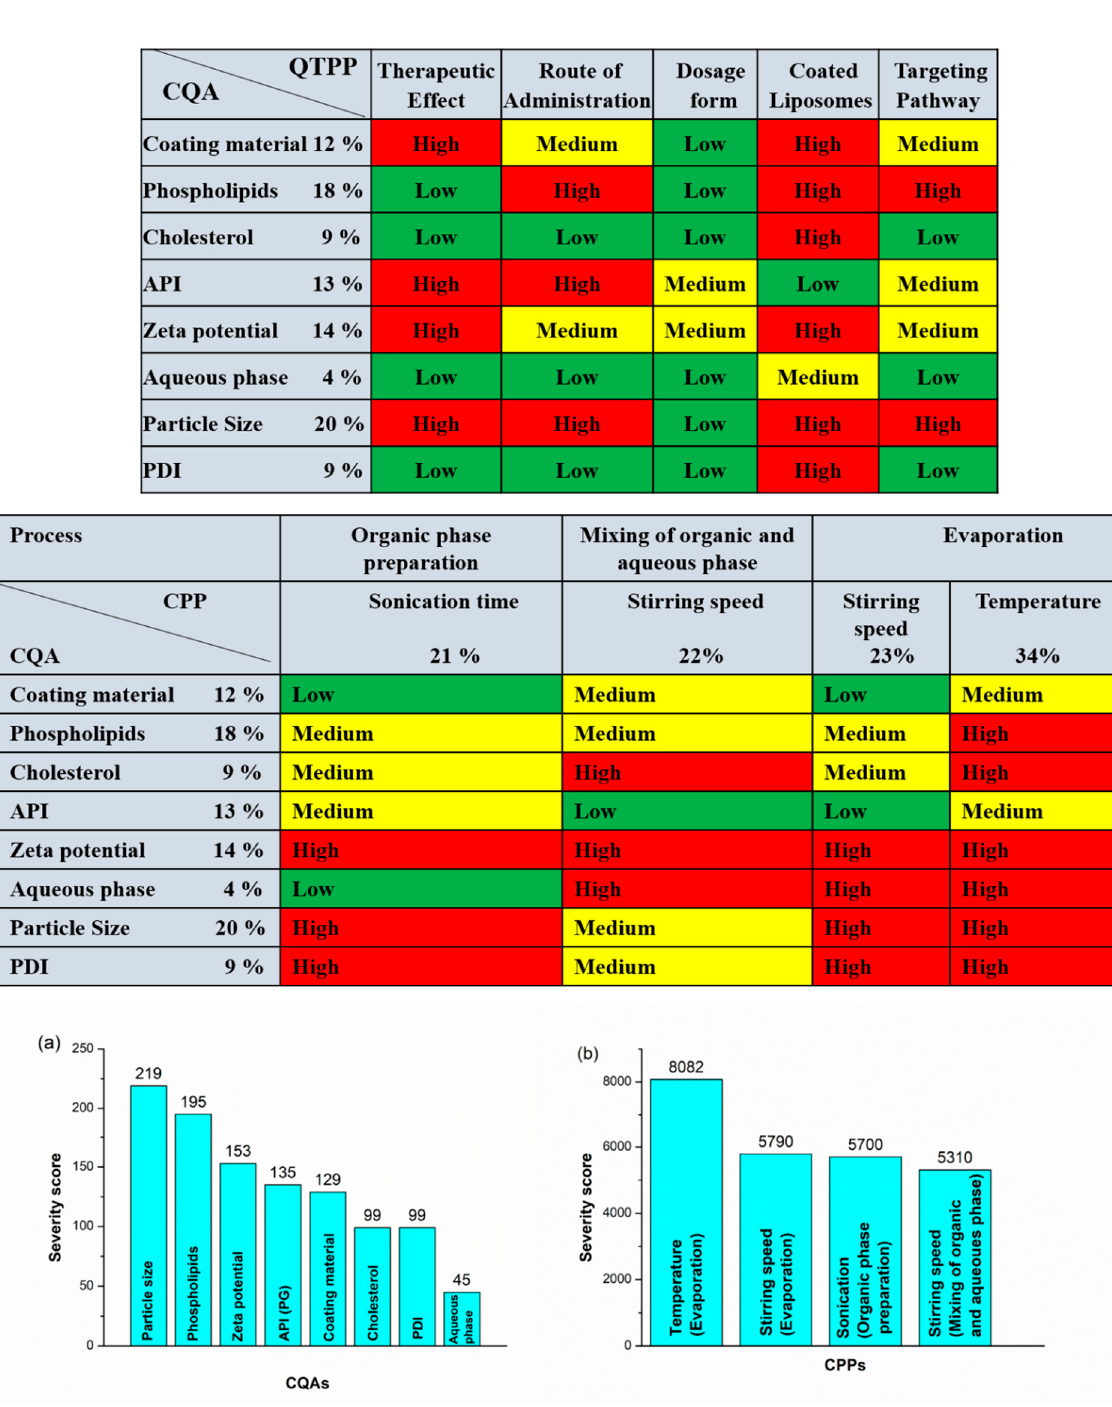
Figure 3. Interdependence rating and estimation of QTPP elements and critical quality attributes (CQAs) and of CQAs and critical process parameters (CPPs), and Pareto charts showing the severity/impact among selected ( a ) CQAs and ( b ) CPPs.